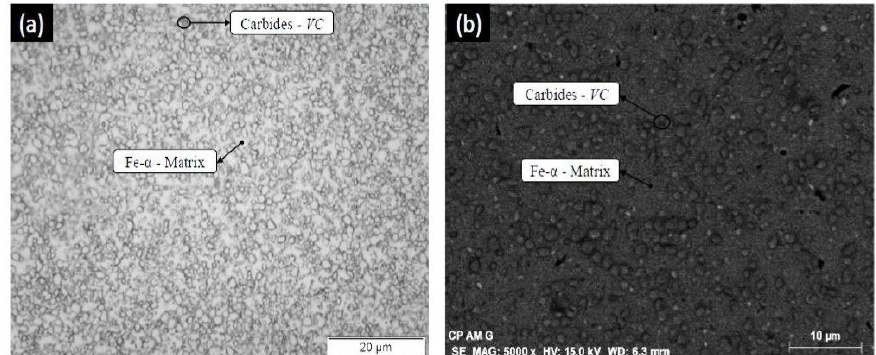
Figure 10: Micrographic analysis of the Vanadis ® 8 as casted (a) Optical microscopy after etching with Nital 4% (1000 x) (b) SEM /